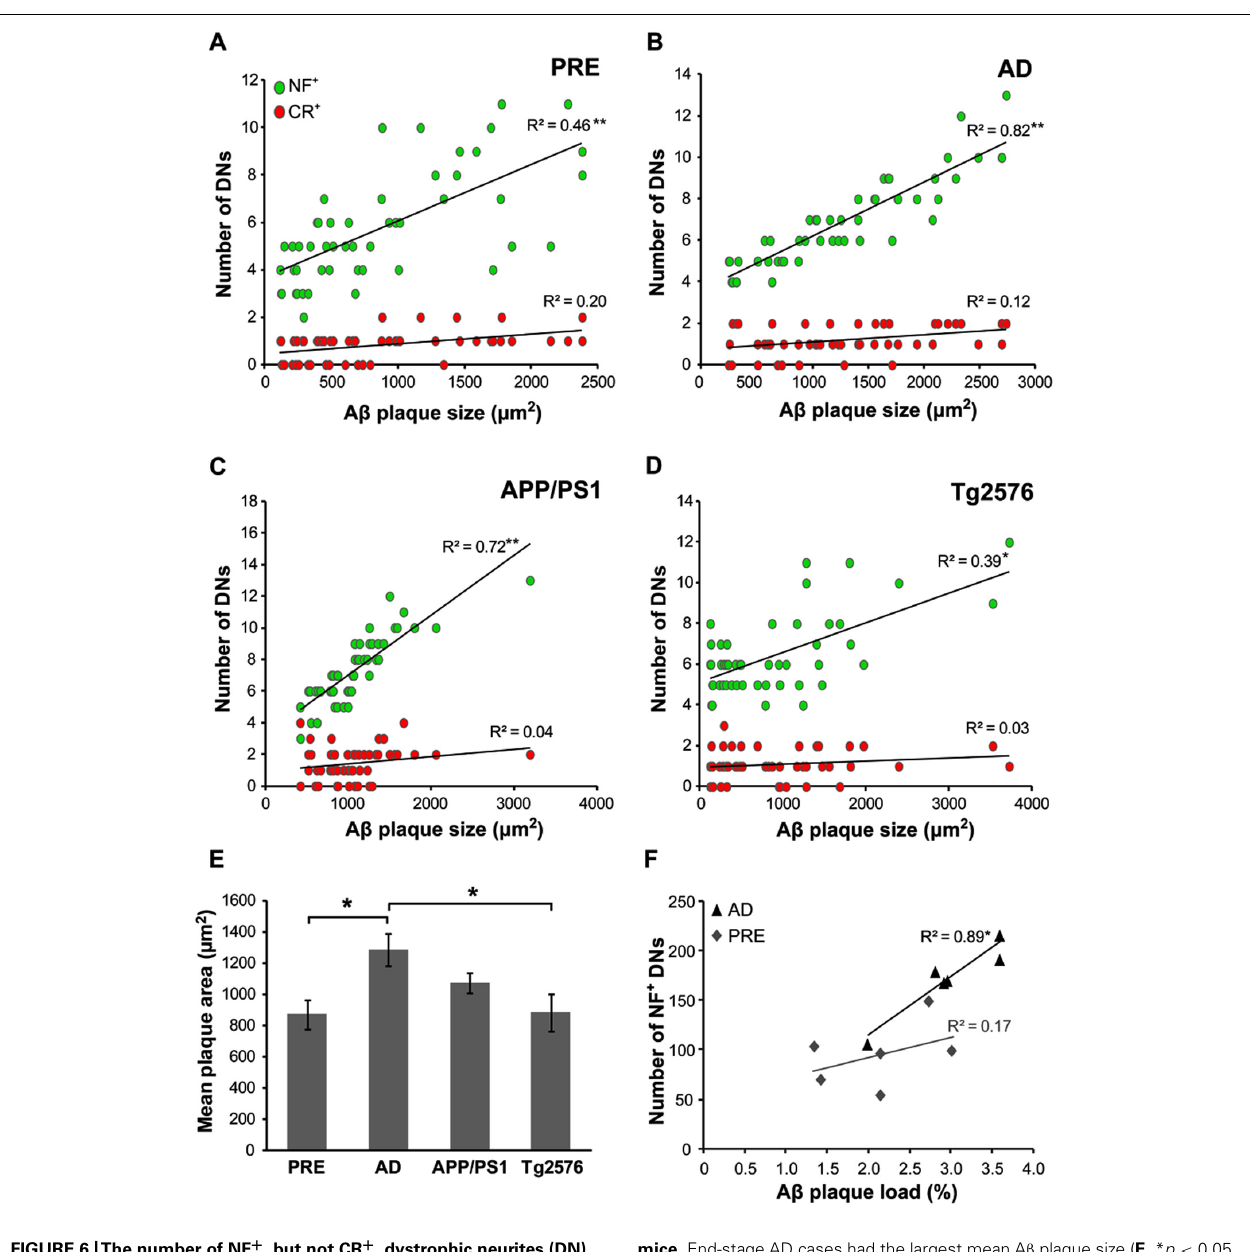
mice. End-stage AD cases had the largest mean A β plaque size ( E , * p < 0.05, t -test). (F) The total number of NF + DNs per case correlated significantly with total A β plaque load in end-stage AD cases but not with preclinical cases ( n = 6 each; * p < 0.01, t -test). Error bars denote standard error of the